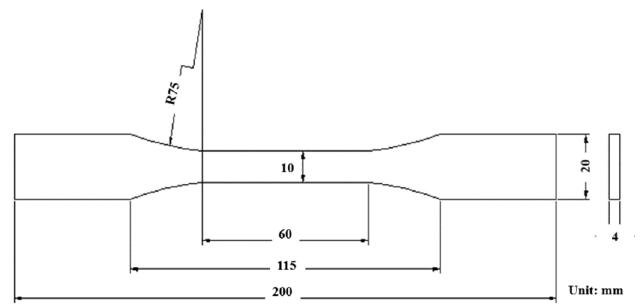
5 of 12 Figure 3. Experimental program flow. The schematic diagram for the preparation of titania-graphene-epoxy composites (TiO 2 -RGO-EP) is shown in the Figure 2. It was of critical importance to obtain a homog- enous epoxy with TiO 2 -RGO nanocomposites. A complex solvent with a xylene-to-N-bu- tanol weight ratio of 7:3 was used to disperse the TiO 2 -RGO nanocomposites and E-44 epoxy, respectively. The TiO 2 -RGO solution was then mixed with the epoxy solution that